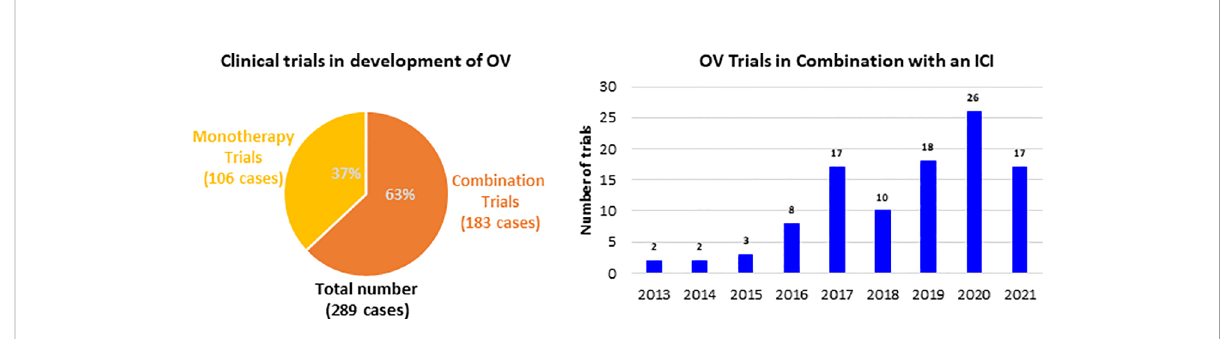
FIGURE 1 Clinical trials investigating OV and number of clinical trials combining OV with